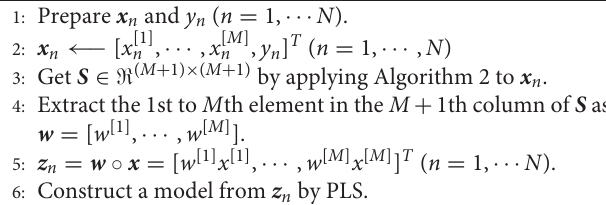
Algorithm 3 Nearest correlation based variable weighting (NCVW)